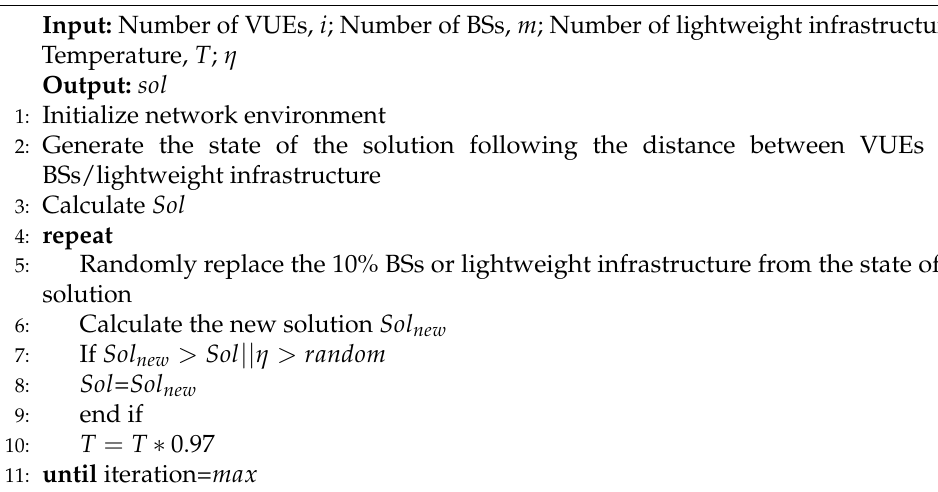
Algorithm 2 Simulate Anneal-based Handover